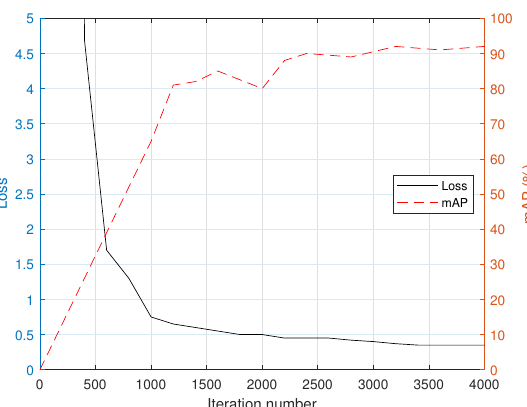
Figure 4. Loss and mAP graph depending on training iteration